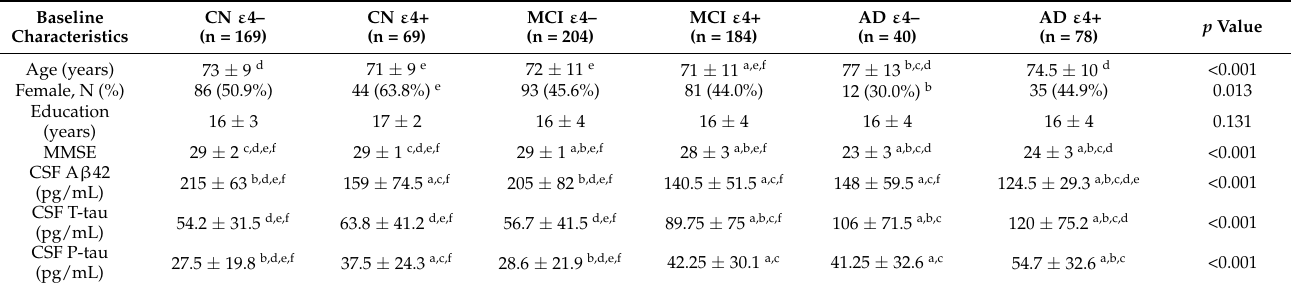
Table 1. Demographics of included participants at baseline.